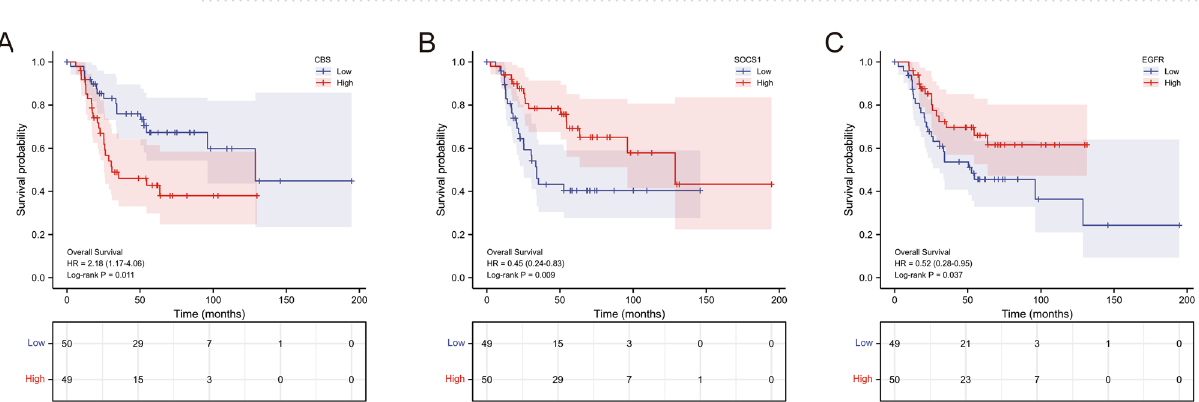
Figure 5. K-M curves of hub genes for OS patients in the TARGET database. ( A ) High expression of CBS was significantly associated with poor survival. ( B ) Low expression of SOCS1 was significantly associated with poor survival. ( C ) Low expression of EGFR was significantly associated with poor survival.